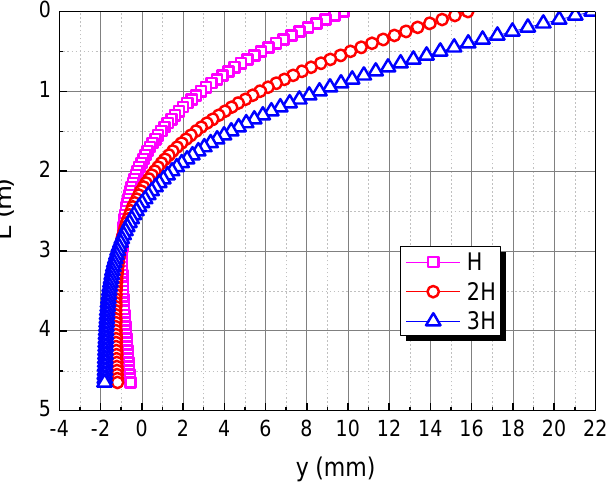
Figure 9. Effect of horizontal load on horizontal displacement of pile in calcareous sand area.